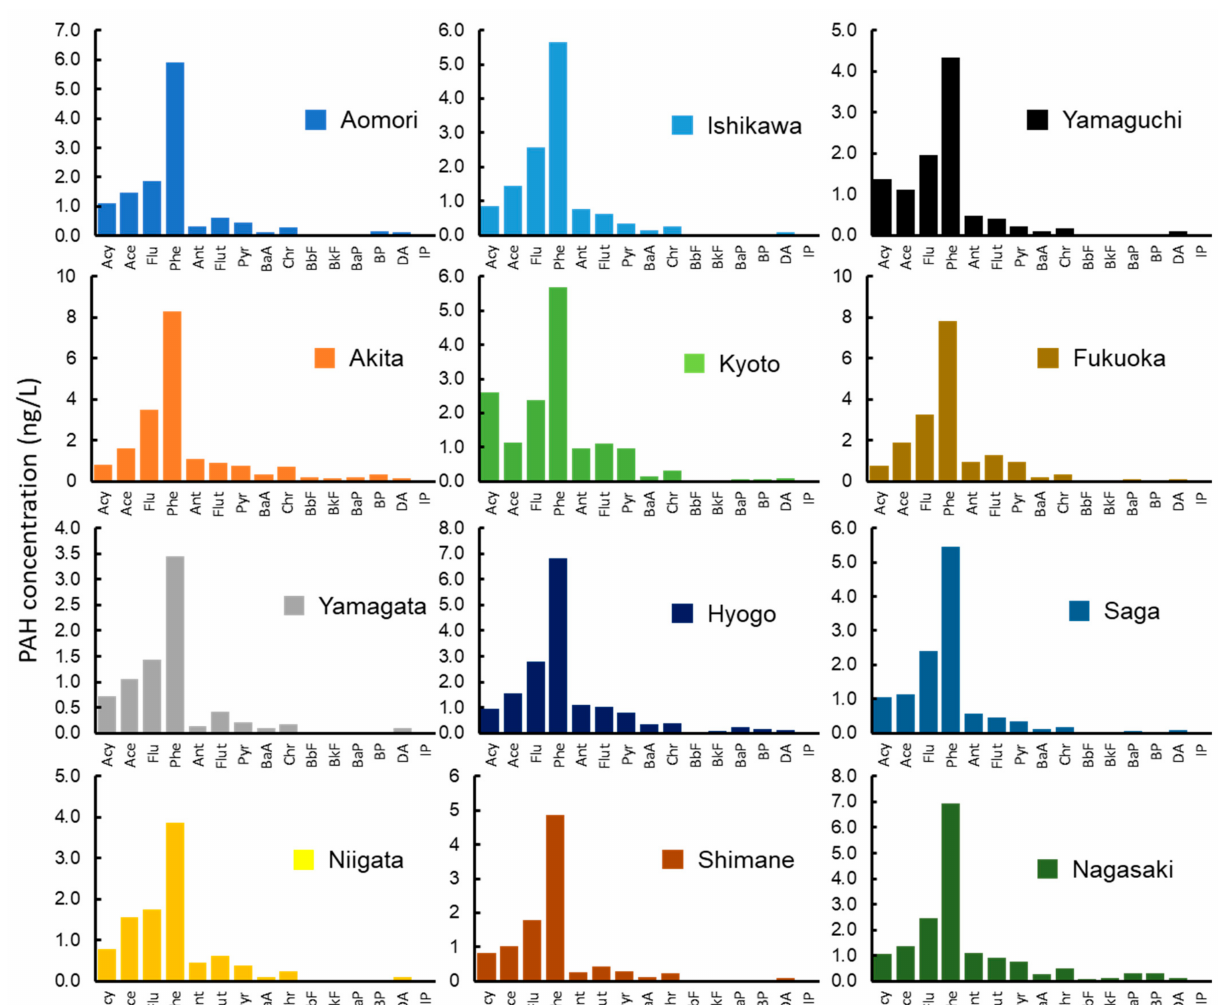
Figure 4. Concentrations of 15 PAHs in seawater (ng/L) collected from 12 sampling